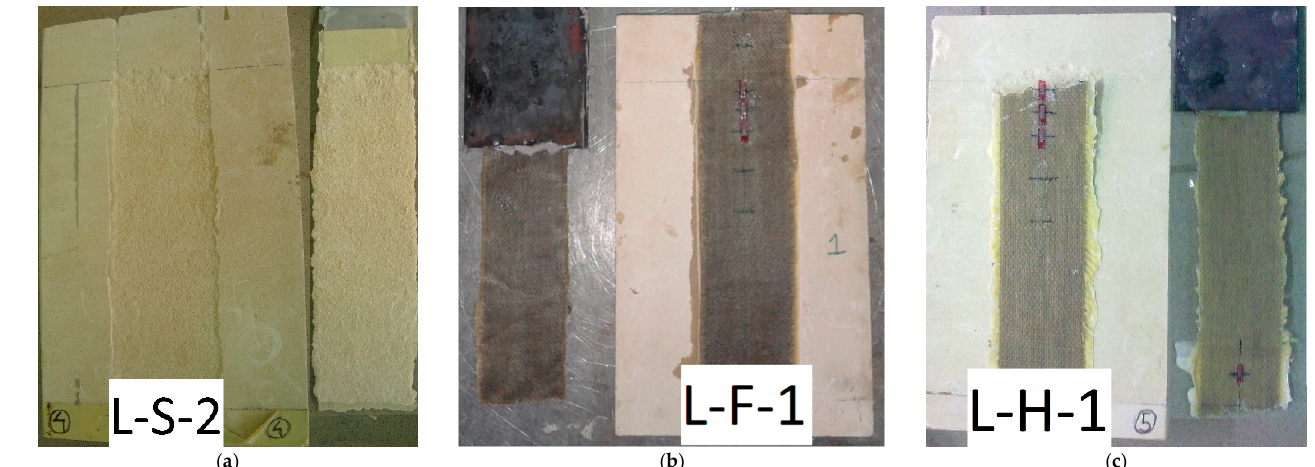
Figure 11. Failure mode for specimens with stone unit substrate: ( a ) L-S; ( b ) L-F; ( c ) L-H.